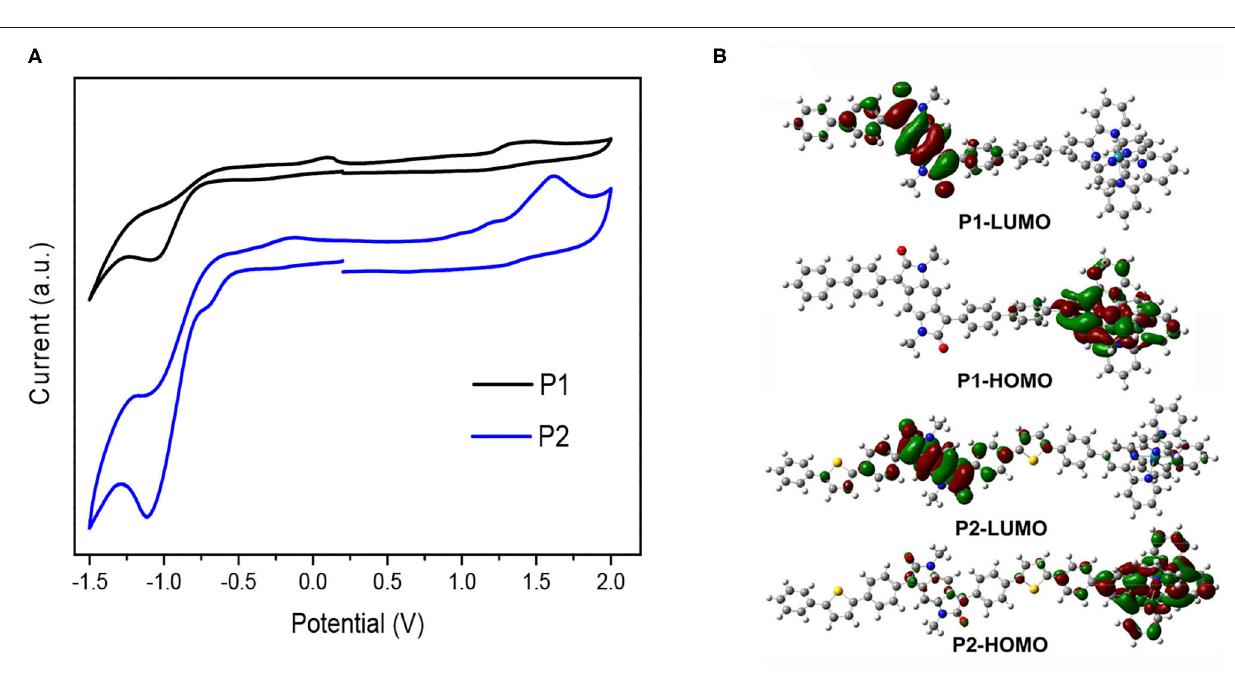
For a better understanding of the electronic properties of the metallo-supramolecular polymers, the molecular orbitals were calculated using density functional theory (DFT) at the B3LYP level using 6-31G(d,p) as a basis set for C, H, N, O, and S atoms and LANL2DZ for Ru. To simplify the calculation, all the alkyl groups were replaced with methyl groups. As shown in Figure 2 , the HOMOs of all the ruthenium-containing polymers P1 and P2 are delocalized along the conjugated backbones of benzene or thiophene rings and mainly in Ru coordinated terpyridine